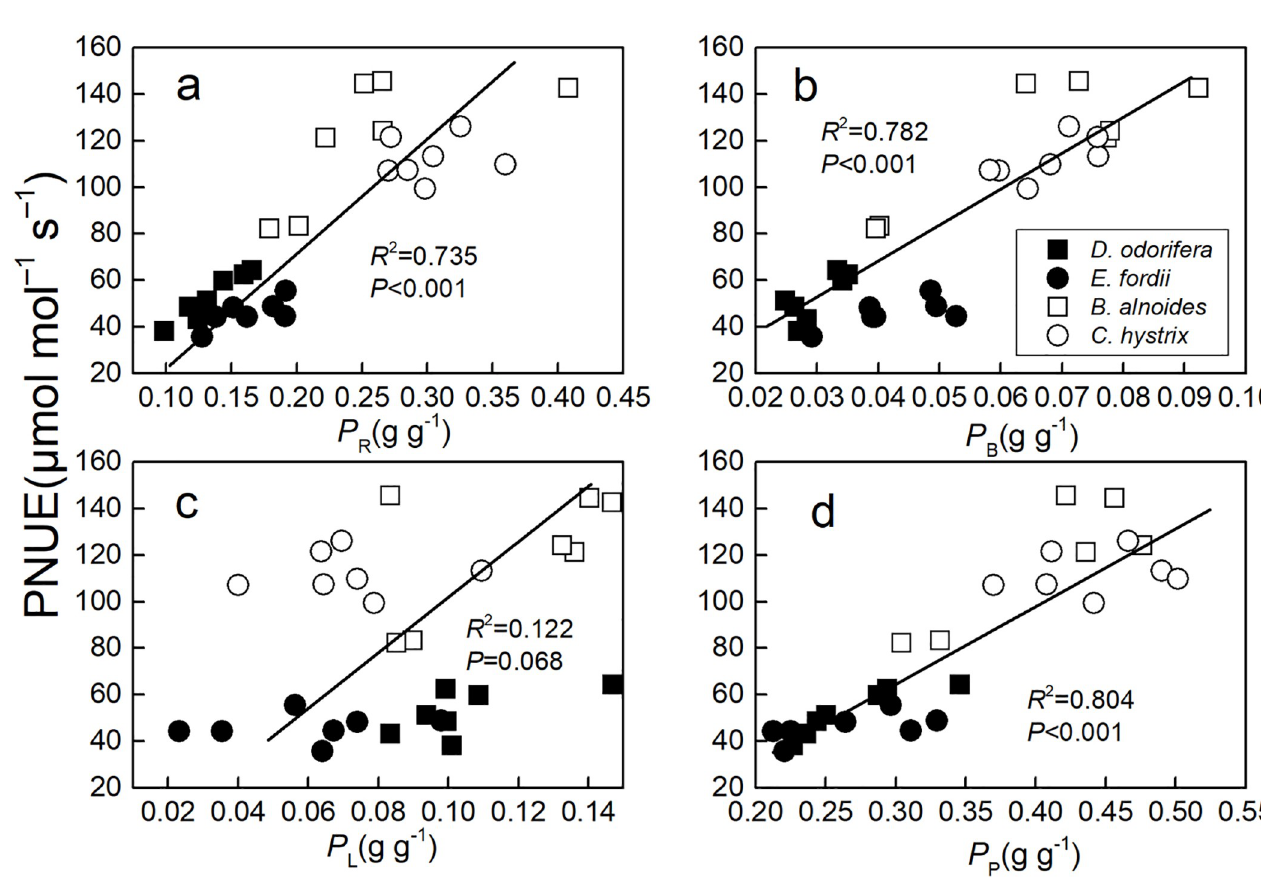
Fig 2. Regression analysis of the fraction of leaf N allocated to (a) Rubisco ( P R ), (b) bioenergetics ( P B ), (c) light-harvesting components ( P L ), and (d) the photosynthetic apparatus ( P P ) with photosynthetic-N use efficiency (PNUE) in four species seedling leaves. The determination coefficient ( R 2 ) and P -value were also shown. Only one line was fitted for four species, because there was no significant difference ( P > 0.05) according to the result of a one-way ANCOVA with PNUE as a dependent variable, tree species as fixed factors, and P R , P B , P L, or P P as a